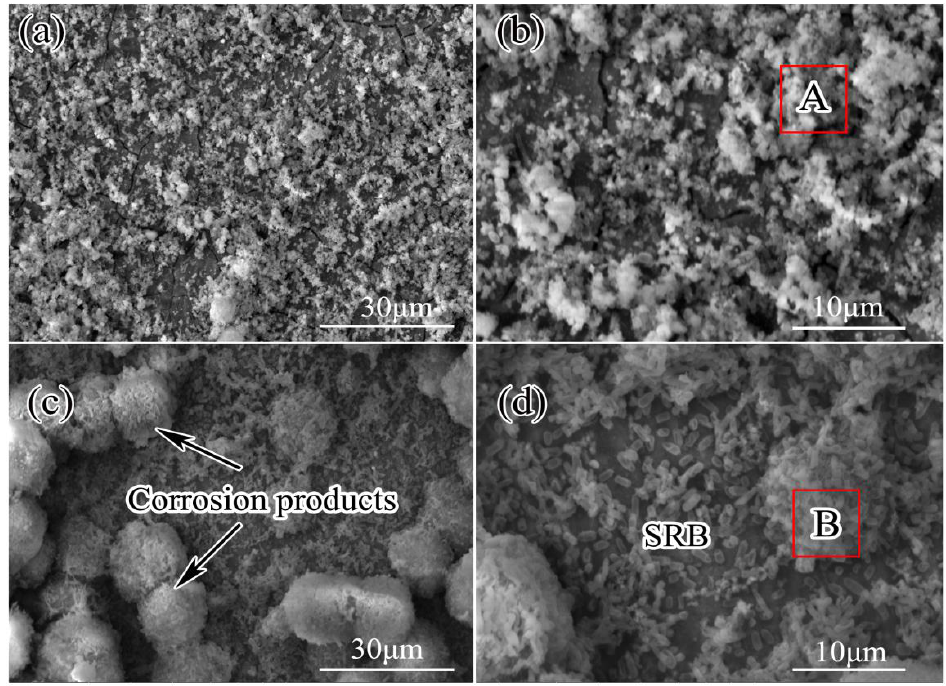
Table 3. Results of EDS of the corrosion products on the steel surface.